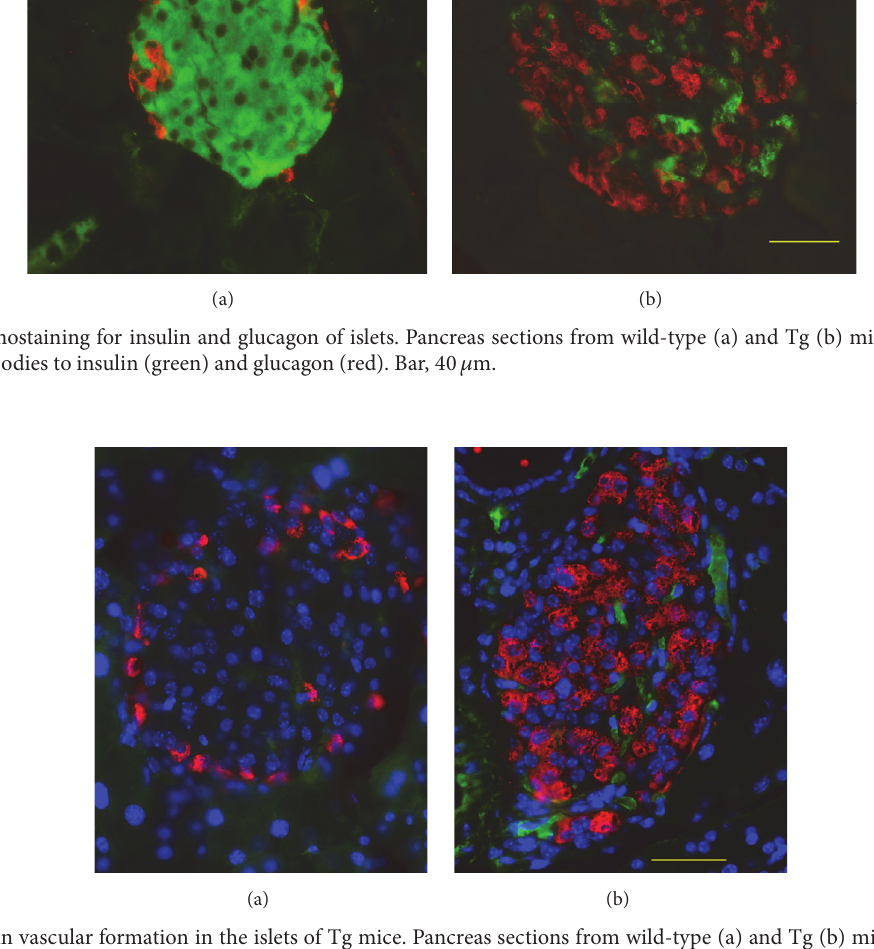
Figure 4: Increase in vascular formation in the islets of Tg mice. Pancreas sections from wild-type (a) and Tg (b) mice at 40 weeks of age costained with antibodies to PECAM1 (green) and glucagon (red) and counterstained with DAPI (blue) for nuclear staining. Bar, 40 𝜇